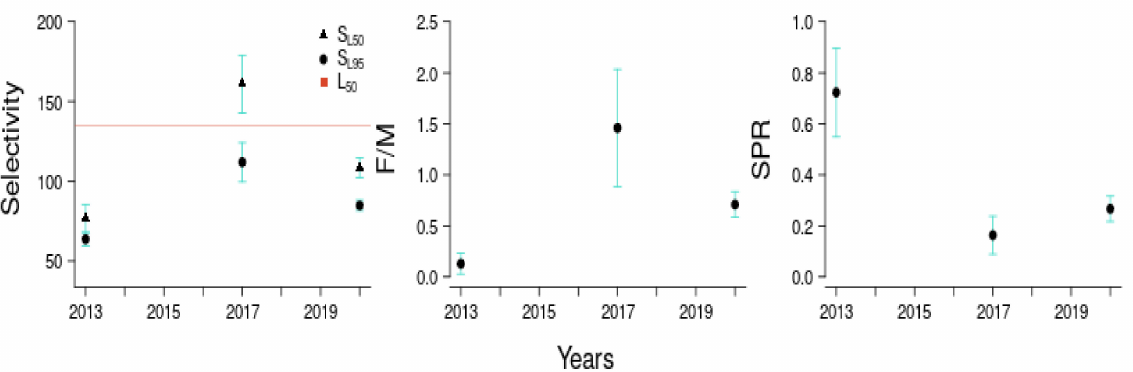
Figure 4. Estimates of selectivity parameters and SPR-based BRPs of the silky shark in the Pacific Ocean. Plot showing estimates when size data are aggregated into a 3-year dataset (2010–2013, 2014–2017, 2018–2020). Red straight line indicates size at 50% maturity (L 50% ). Green lines indicate confidence intervals.